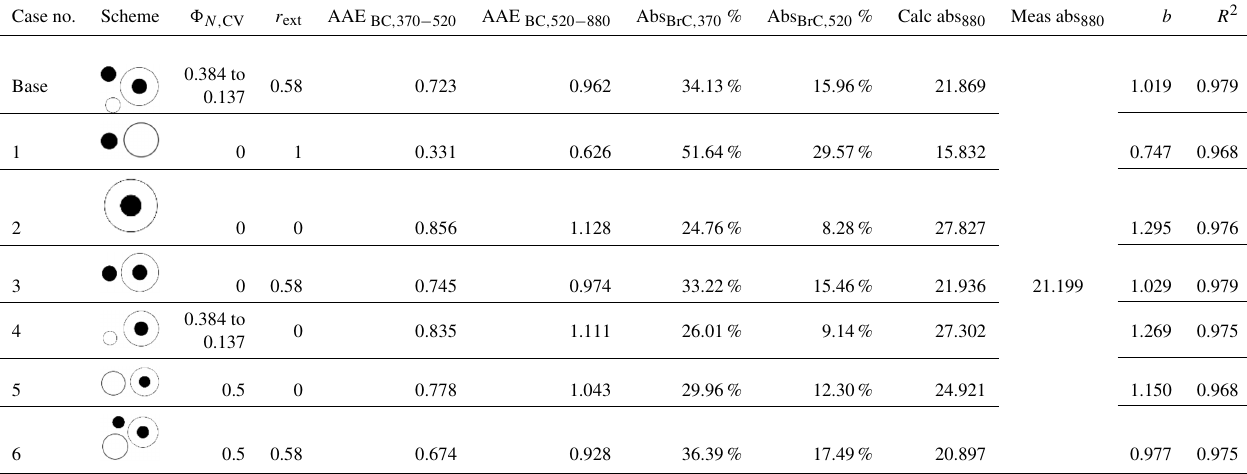
Table 1. Intercomparison of the performance of various Mie-calculation schemes. Base Case is based on the empirical distribution function and mixing states of BC particles obtained from previous field measurements at the same site. (cid:56) N, CV denotes the portion of non-BC particles, and r ext is the mass portion of externally mixed BC with respect to total BC. AAE BC is the absorption Ångström exponent of BC, and the subscript represents the wavelength range. Abs BrC , 370 % and Abs BrC , 520 % are the BrC absorption contributions at 370 and 520nm, respectively. Calcabs 880 is the calculated absorption at 880nm using the Mie model. Measabs 880 is the measured absorption by an Aethalometer at 880nm. b is the intercept of the regression analysis between Measabs 880 and Calcabs 880 , i.e., Calcabs 880 = b ∗ Measabs 880 . R 2 is the correlation coefficient of the equation. The refractive index of BC core ( e m core ) and non-light-absorbing particles ( e m non ) is set to be 1.80–0.54 i and 1.55–10 − 7 i , respectively (Tan et al.,